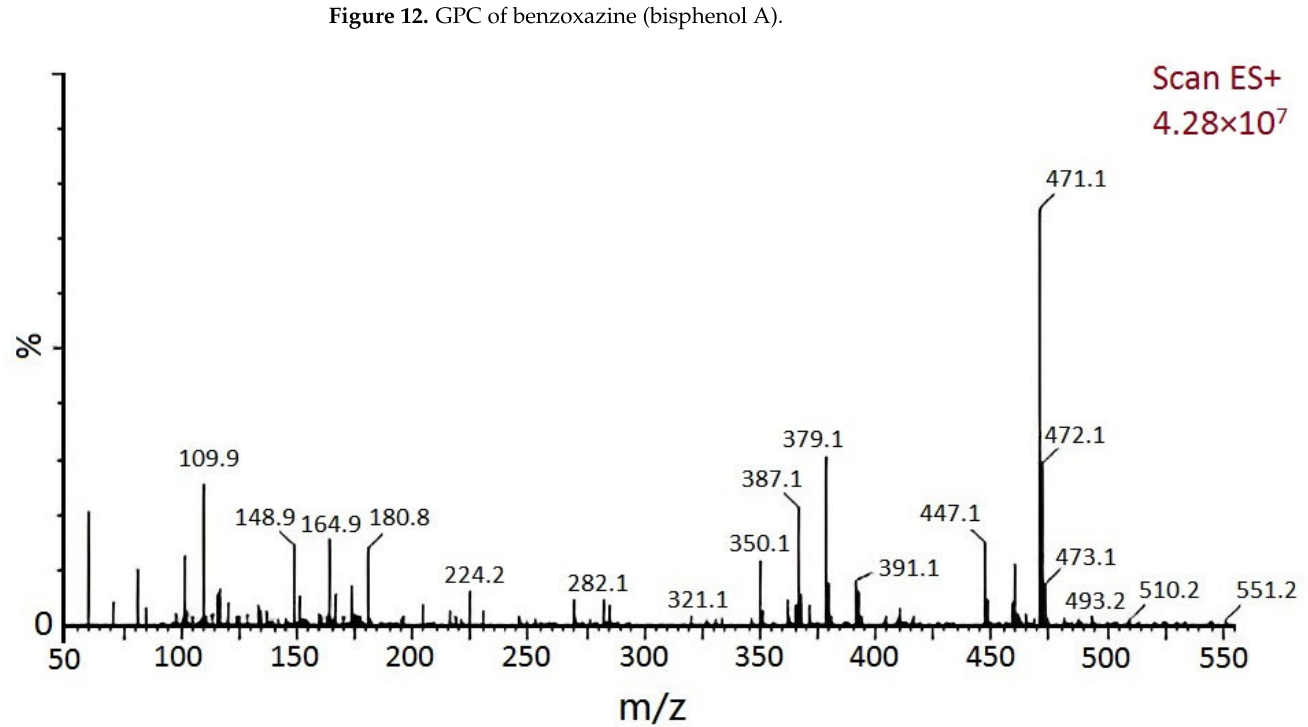
Figure 13. Mass spectrogram of benzoxazine (bisphenol A).